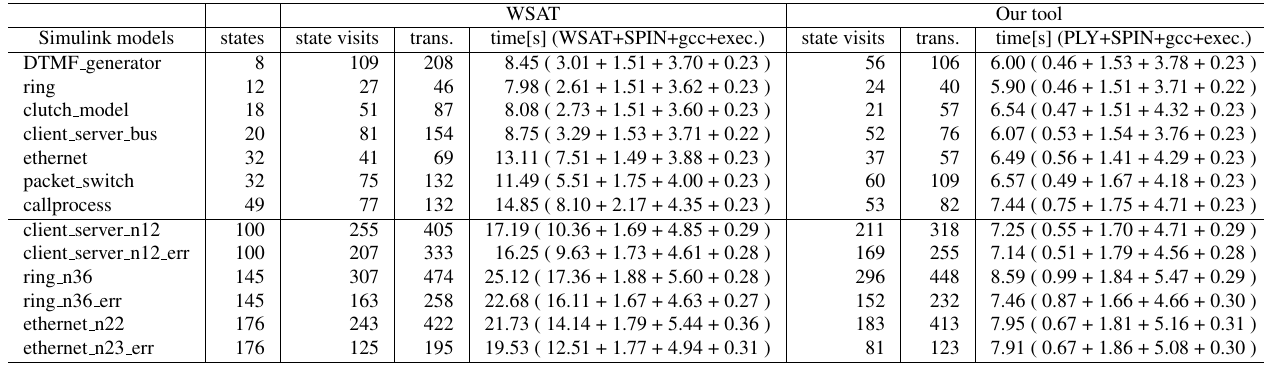
Table 4: Experimental results for checking liveness (nondeterministic) WSAT Our tool Simulink